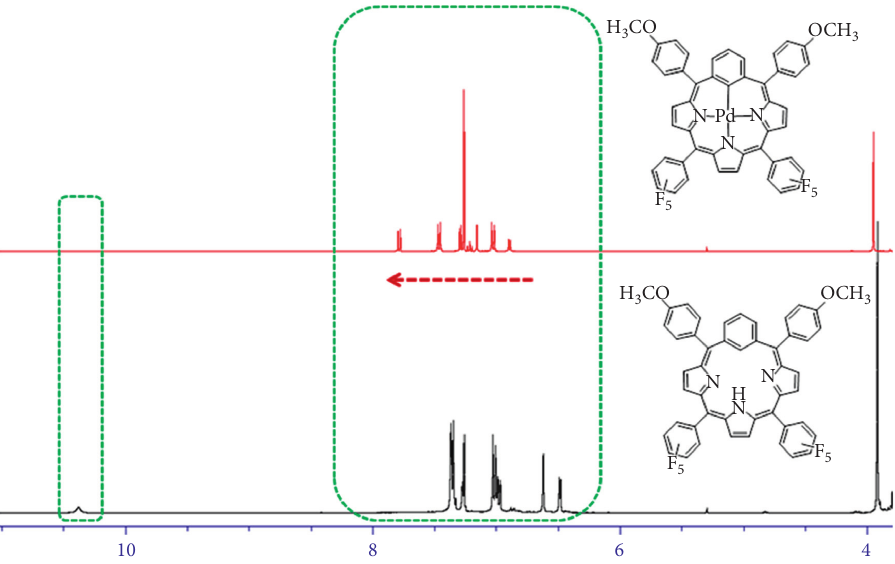
Figure 3: 1 H NMR of benziporphyrin 2 and its Pd complex benziporphyrin 1 in CDCl